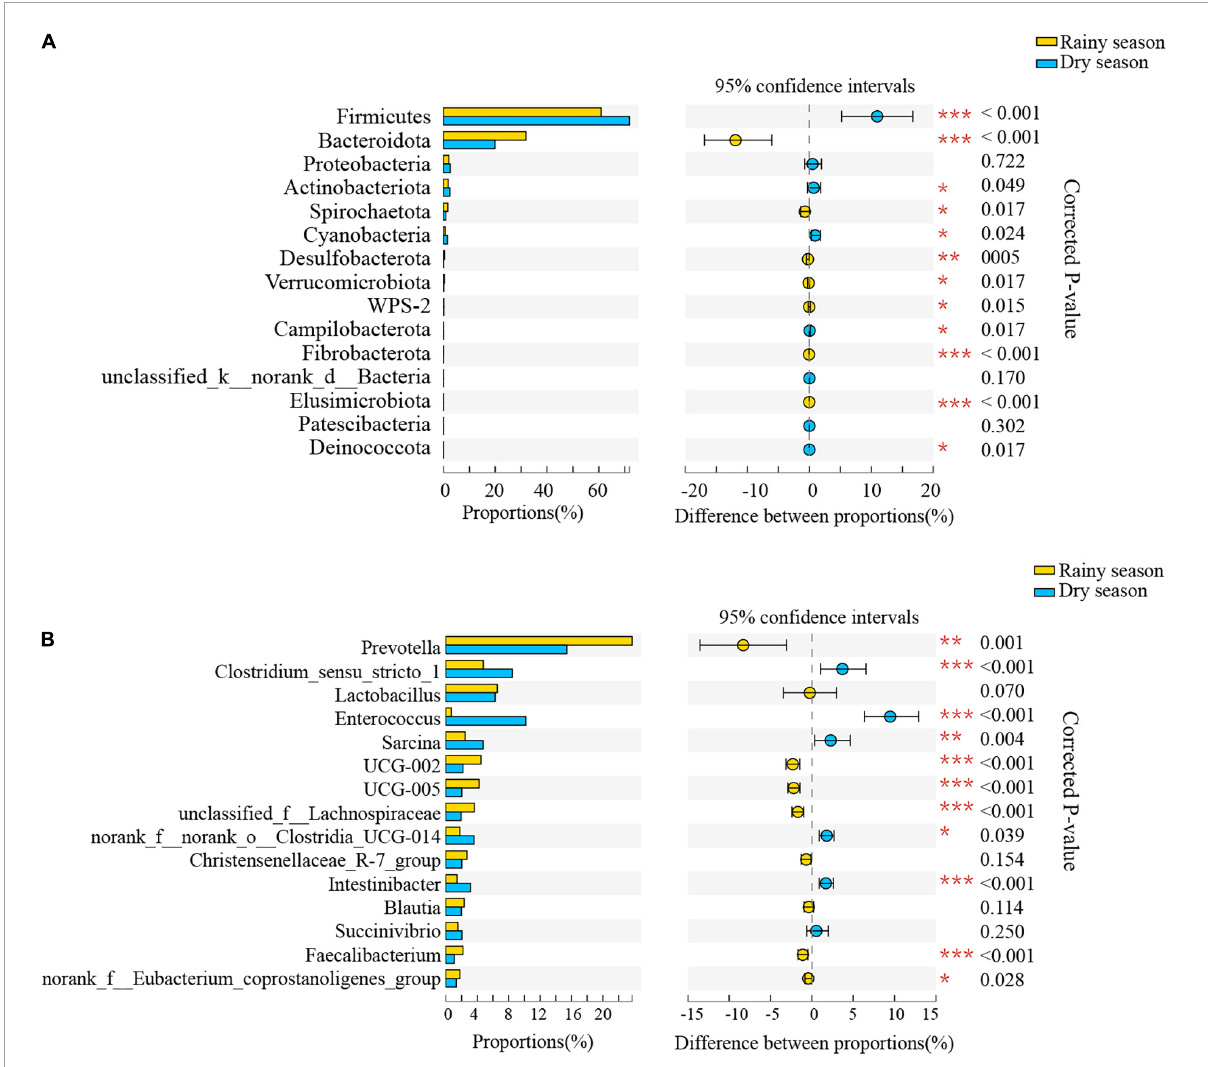
FIGURE5 The composition difference analysis in the gut microbiota community at the phylum (A) and genus (B) levels. Only the top fifteen bacterial taxa are displayed. Asterisks indicated a significant difference, with “*” for p < 0.05, “**” for p < 0.01, and “***” for p <